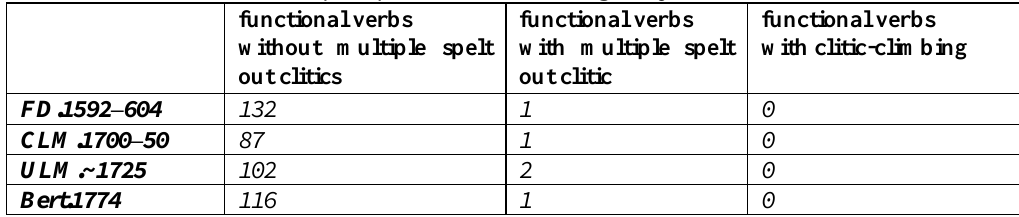
functional verbs with clitic-climbing